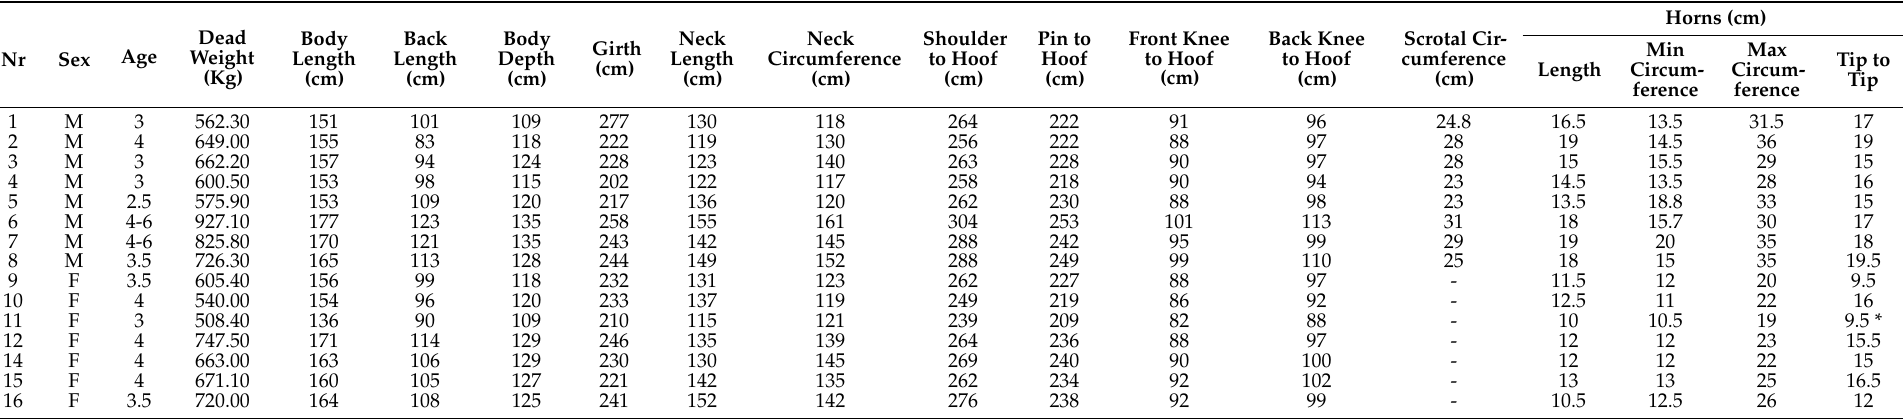
Table A1. Body and horn measurements of 15 giraffe ( G. c. angolensis ) from the Otjozondjupa region of